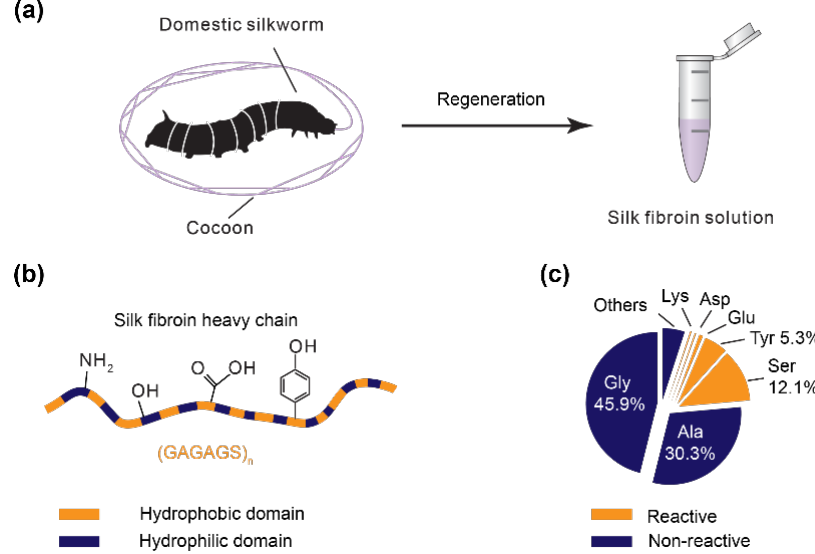
Figure 1. ( a ) Silk fibroin solution is regenerated from the cocoons of domestic B. mori silkworms. The